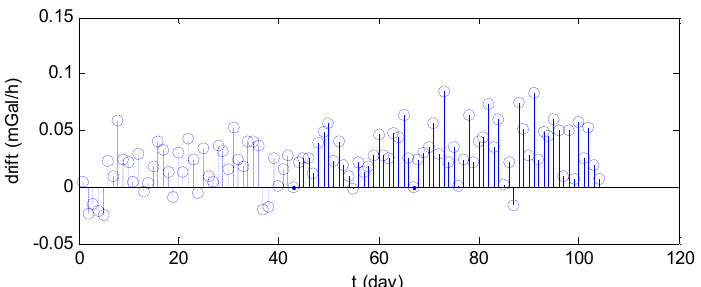
Figure 6. Drift in gravimetric data with